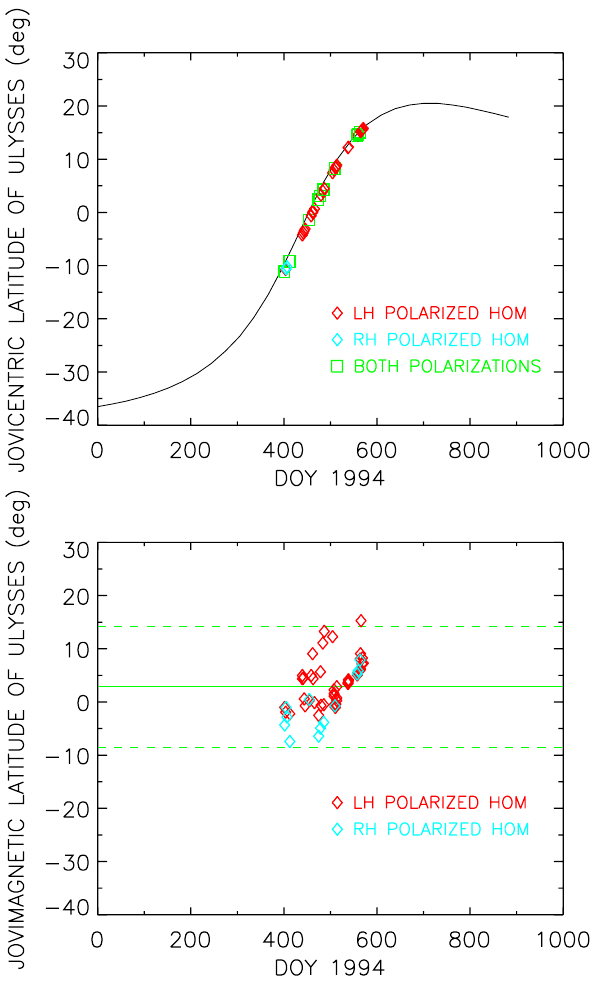
Fig. 4. Days on which HOM events were observed by Ulysses, dur- ing the period 940101 to 960229 (DOY 94001 to 94790), against (a) jovicentric latitude and (b) jovimagnetic latitude of the spacecraft.